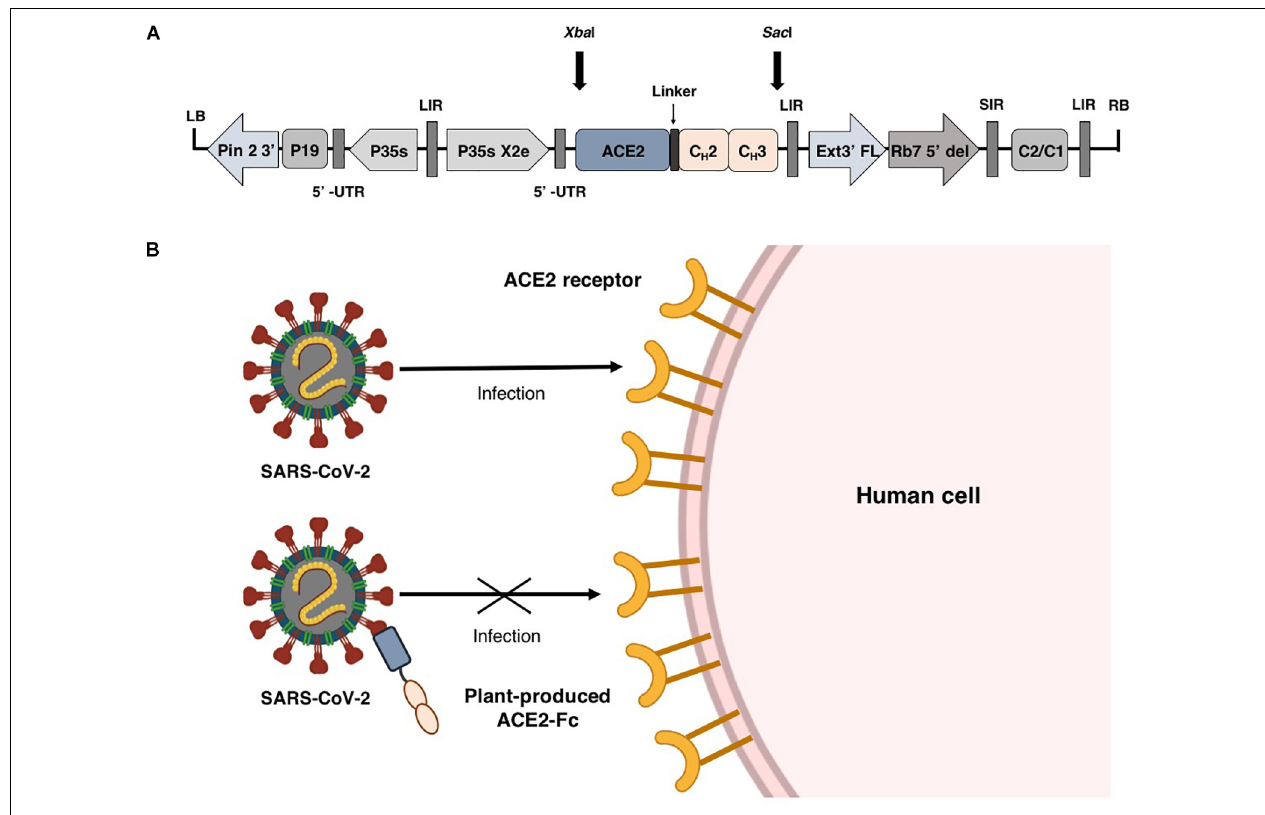
FIGURE 1 | Schematic representation of plant expression vector pBYR2e-ACE2-Fc used in the present study (A) . Diagrammatic representation showing the binding of plant-produced ACE2-Fc with SARS-CoV-2 thereby preventing the virus entry into the host cell (B)